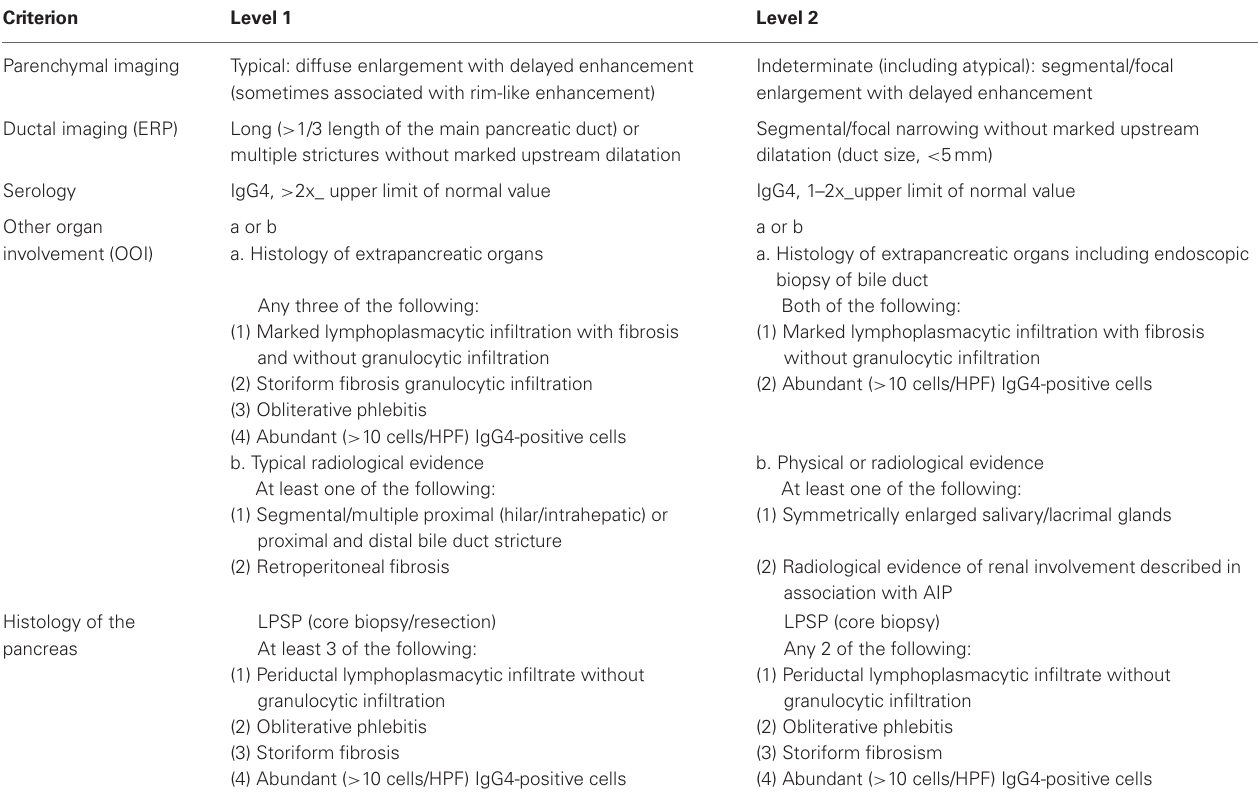
Table 1 | Level 1 and level 2 criteria for Type-1 AIP.